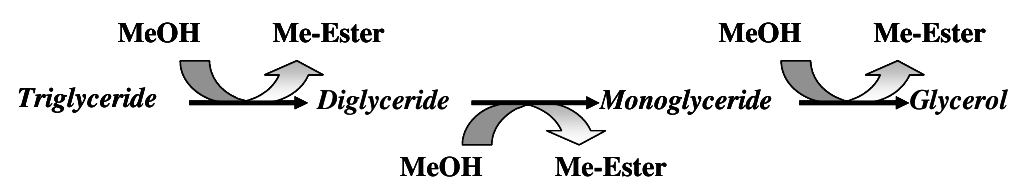
Fig 6. The overall transesterification process of a vegetable